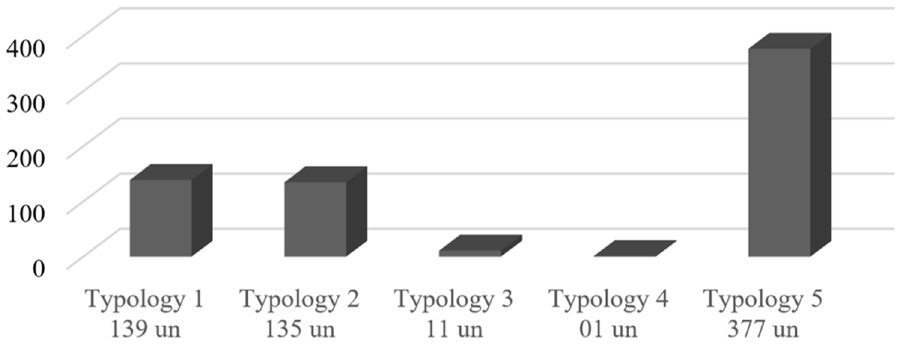
Figure 2. Histogram of the building typologies identified in the survey.